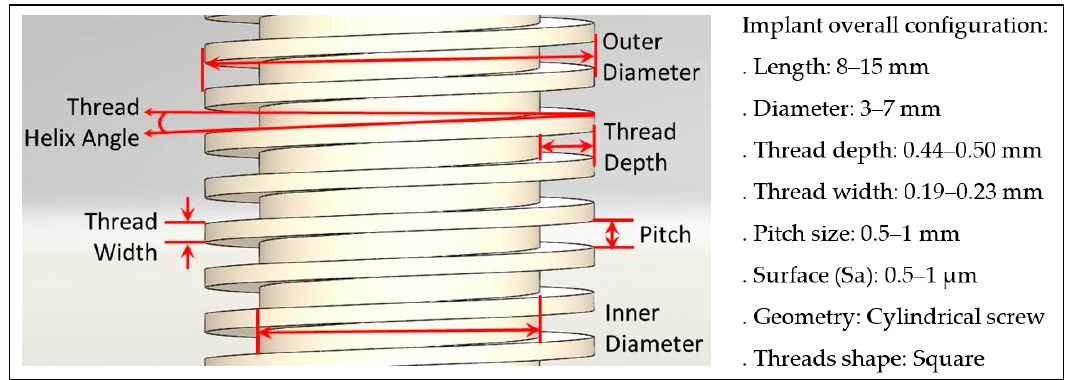
Figure 1. The overall design and characteristics of commercial dental implant threads [1,13,14,20–22].